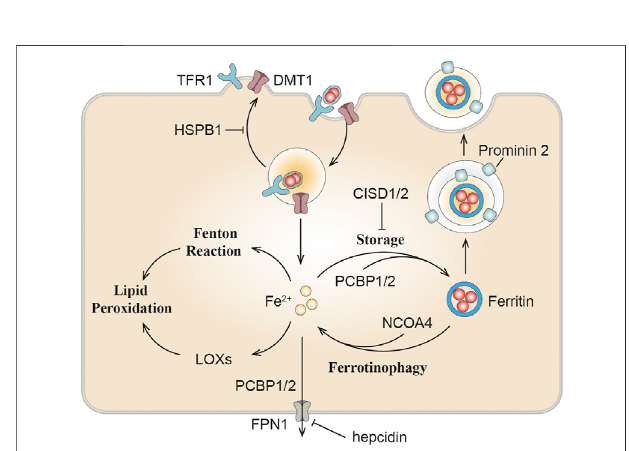
FIGURE 2 | The role of iron metabolism in ferroptosis. Iron homeostasis ortransportationincludingcanin fl uenceferroptosissensitivity.DMT1,divalent metal transporter 1; TFR1, transferrin receptor 1; NCOA4, nuclear receptor coactivator 4; PCBP, Poly(rC) binding protein; LOXs, lipoxygenase; HSPB1, heat shock protein beta-1; CISD, CDGSH iron-sulfur